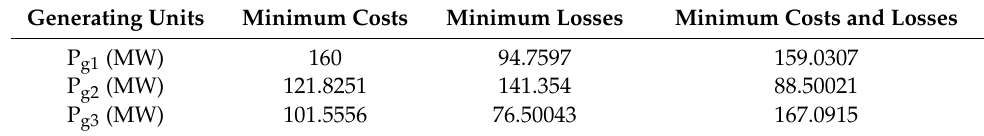
Table 2. Optimal fossil fuel power considering different objective functions for Garver system.